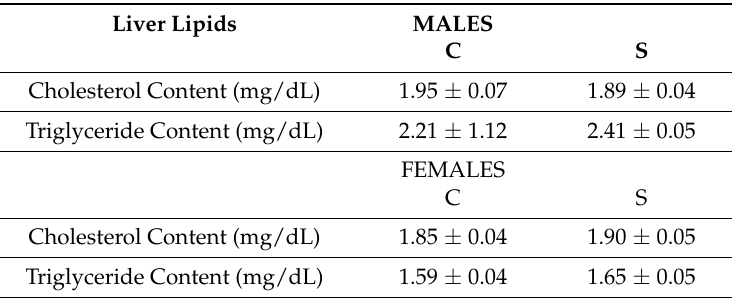
Table 2. Liver lipid levels of adult offspring programmed by smoke exposure. Liver